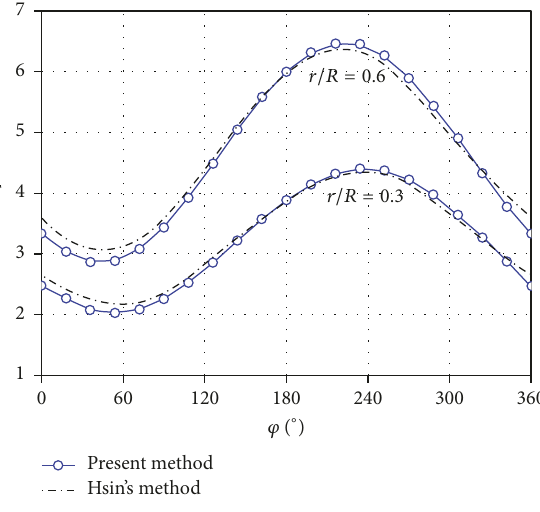
Figure 2: Comparison with Hsin’s method.